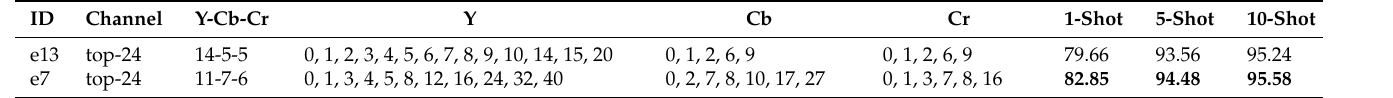
Table 2. The results of different channel selection strategies. e13 uses the frequency combination for ImageNet; e7 uses the frequency combination for setting-2. ( f θ : Resnet12; method: f; data: setting-2; filter-size: 8 × 8).